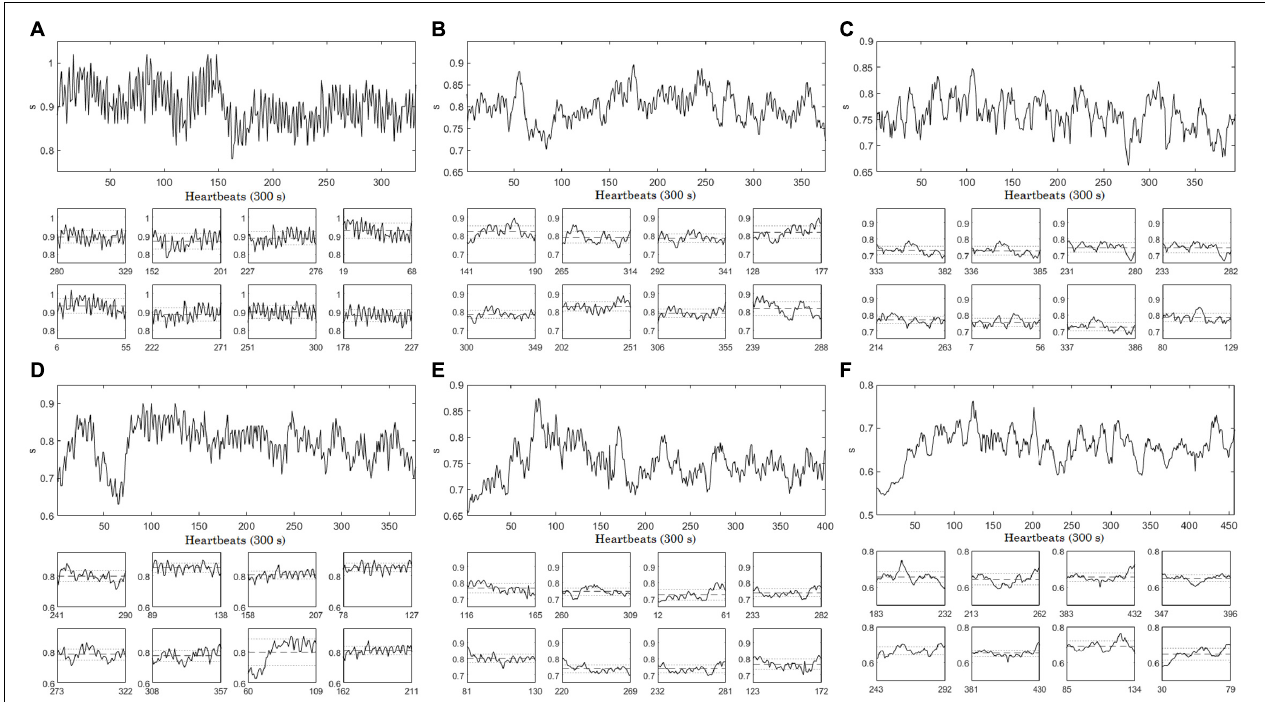
FIGURE 5 | Examples of nonstationary heart rate variability (HRV) time series. Full-size panels show the whole HRV time series in supine position (top row) of (A) healthy subject, (B) end stage renal disease (ESRD) patient before hemodialysis (HD), and (C) ESRD patient after HD (same individual). HRV time series collected at active standing (bottom row) from (D) healthy subject, (E) ESRD patient before HD, and (F) ESRD patient after HD. HRV time series units in all panels are shown as seconds